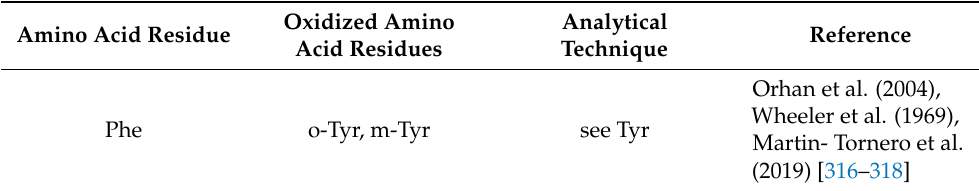
Figure 3. Chemical structures of Phenylalanine and common Phenylalanine photo-oxidation products such as ortho- and meta-Tyr. Table 7. Analytical techniques/assays to detect Phe oxidation products with the corresponding analytical techniques and relevant